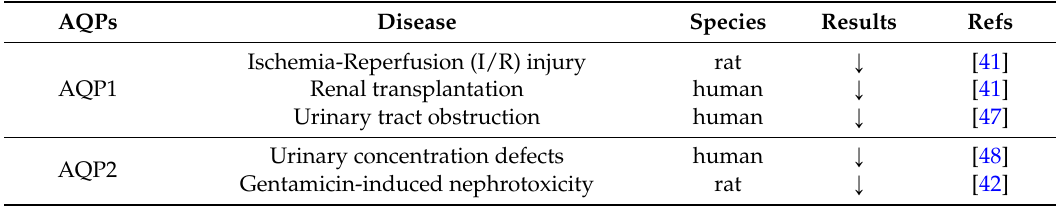
Table 1. Urinary exosomal aquaporins (AQPs) related to kidney disease. AQPs Disease Species Results Ischemia-Reperfusion (I/R) AQP1